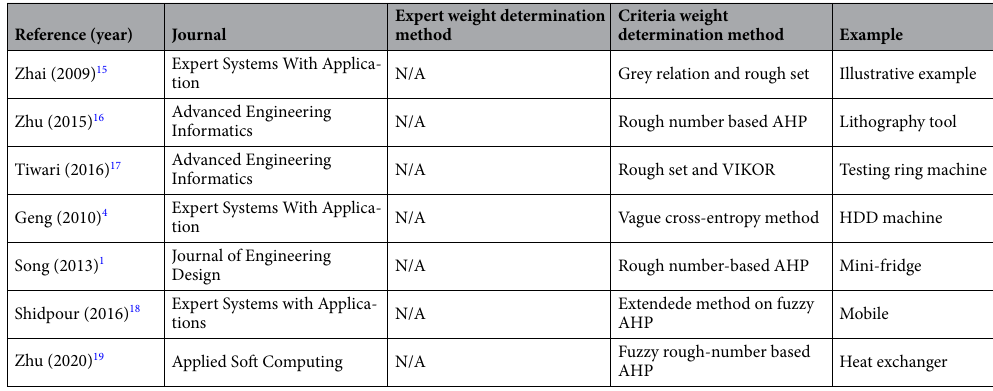
Table 1. Highest cited studies in design concept evaluation.